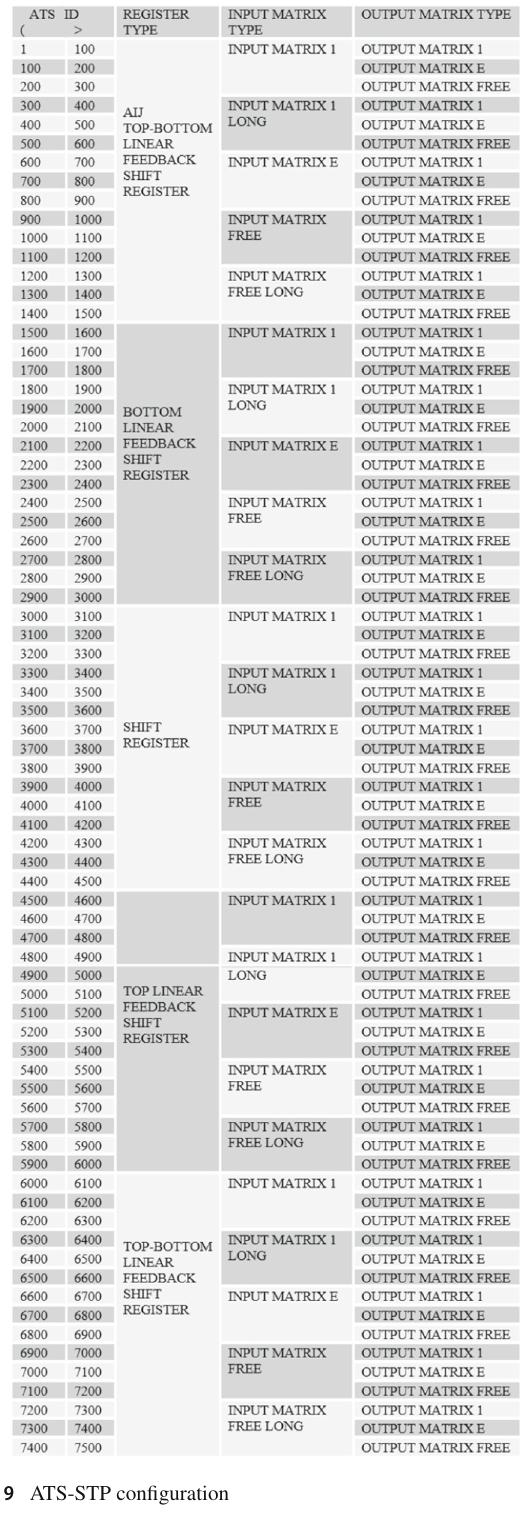
where x 0 is a length of sequence, x 1 is a number of ExORs used to create additional linear feedback, x 2 is a number of T-type flip-flops used to design NLFSR and